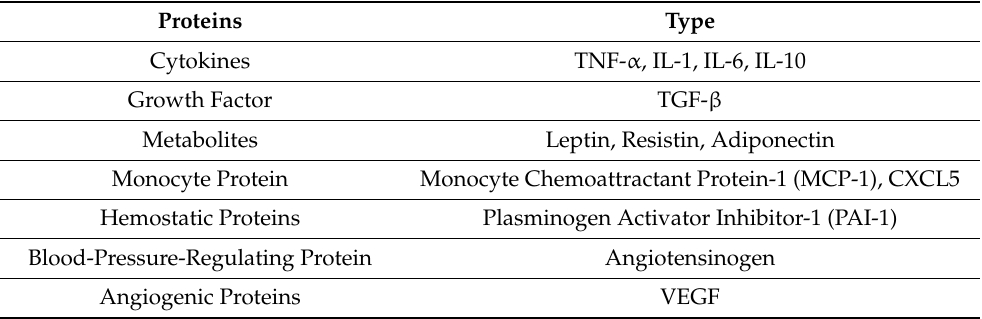
Table 1. List of proteins secreted by adipocytes during normal conditions and